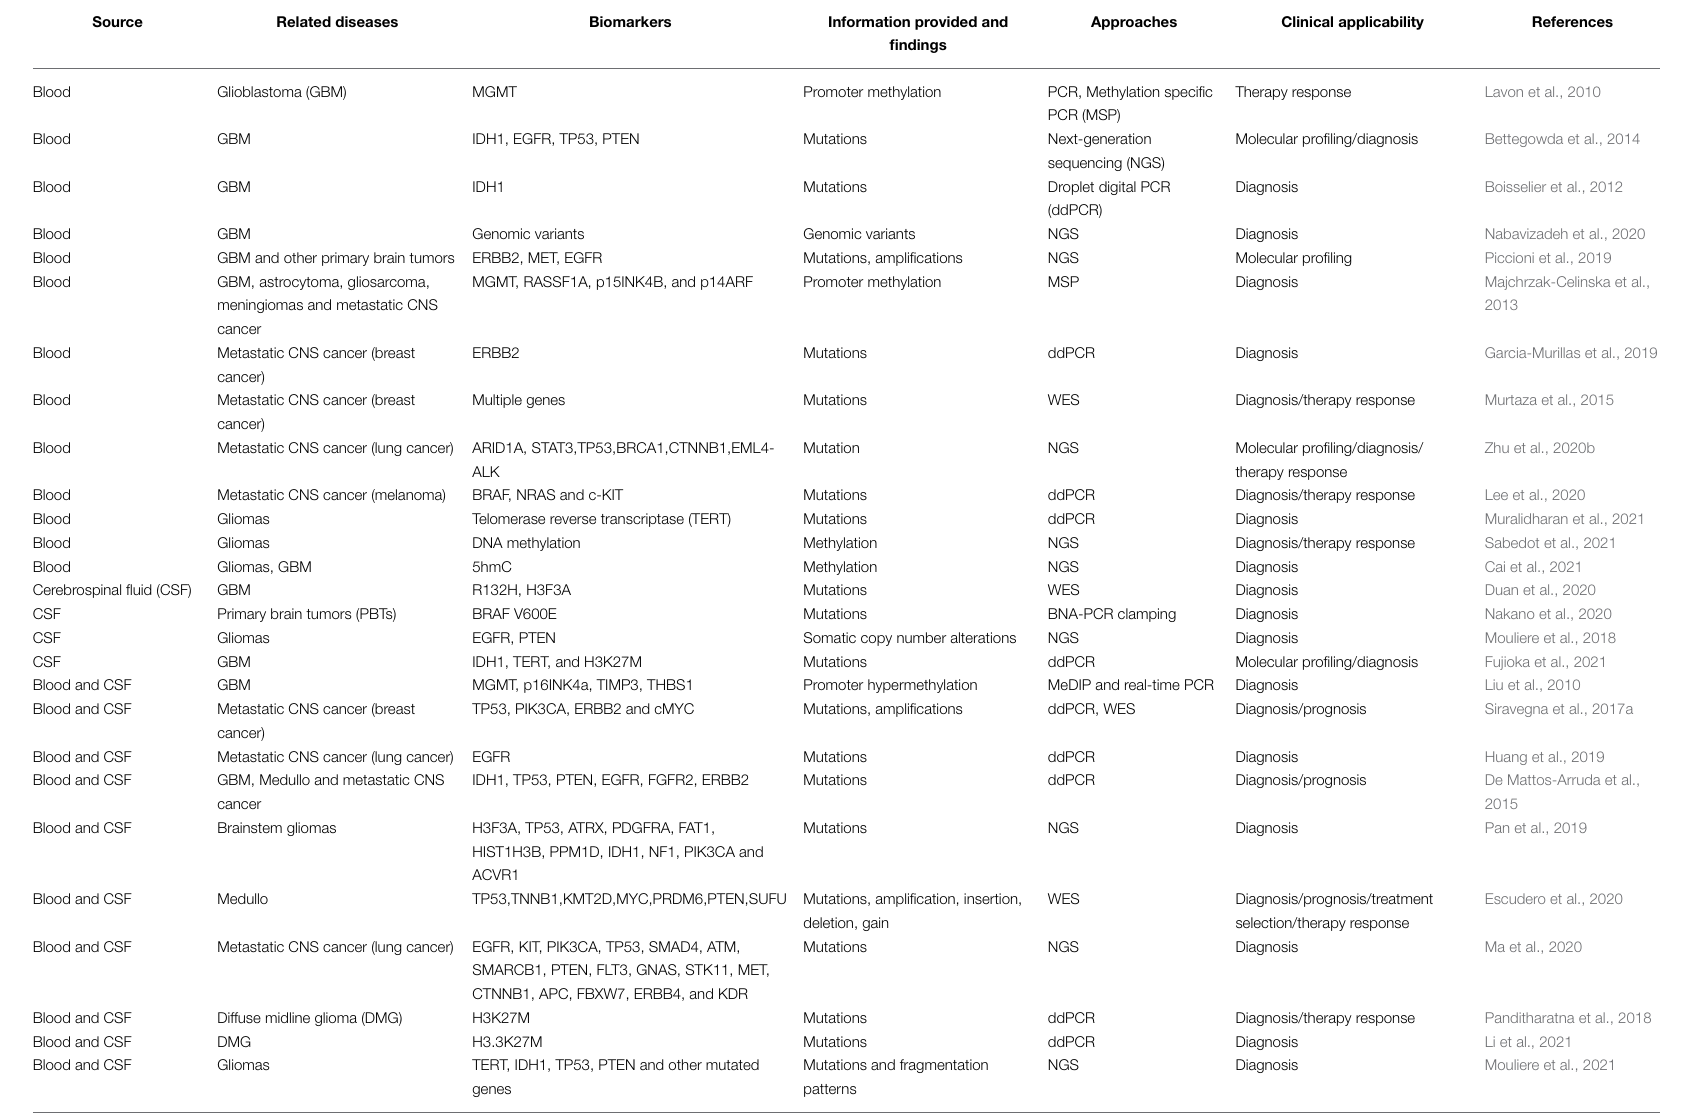
TABLE 1 | Recent studies in brain cancer diagnosis.